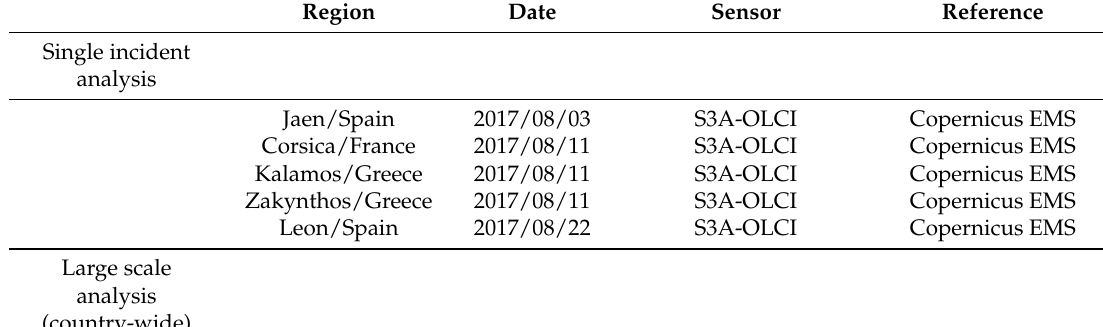
Table 1. Listing of the study areas and utilized reference data sources. Region Date Sensor